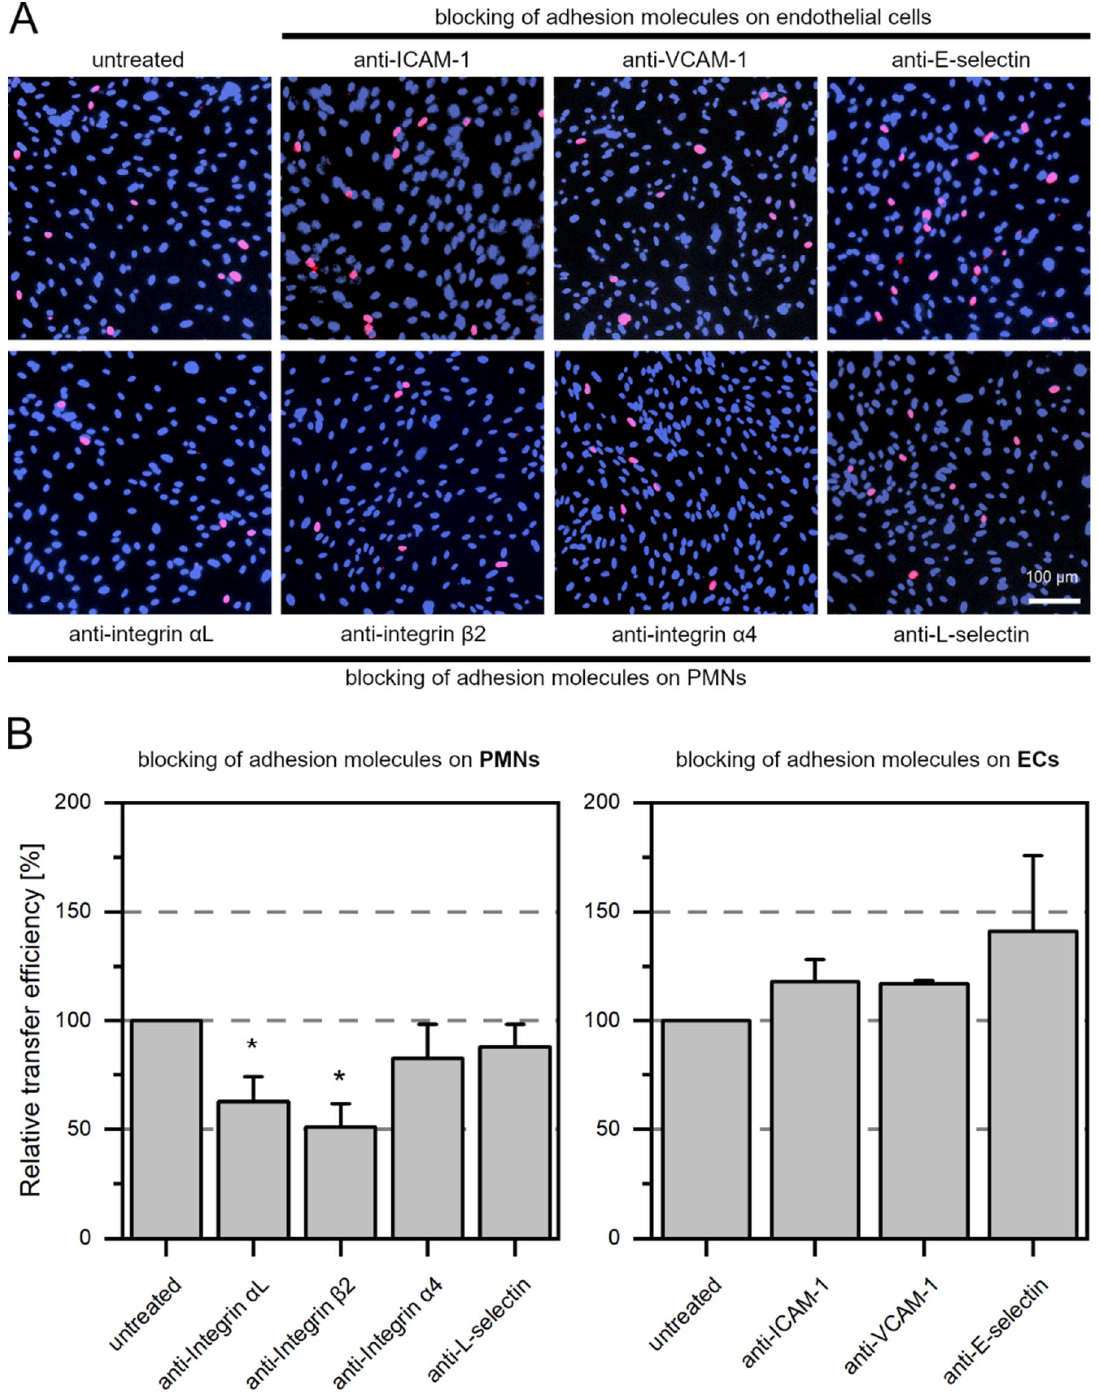
Figure 8. Blocking of LFA-1 subunits αL or β2 reduces the efficiency of HCMV transfer via PMNs. PMNs were isolated from EDTA blood of HCMV-seronegative donors and incubated for 3 h at 37 °C with clinical isolates. PMNs were recollected and either left untreated or were treated for 30 min at 37 °C with 10 μg/mL anti-integrin αL, 20 μg/mL anti-integrin β2 (both are subunits of LFA-1), 5 μg/mL anti-integrin α4 (subunit of VLA-4) or 25 μg/mL L-selectin. Simultaneously, the recipient HEC-LTTs were either left untreated or were treated with 25 μg/mL anti-E-selectin, 25 μg/mL anti-